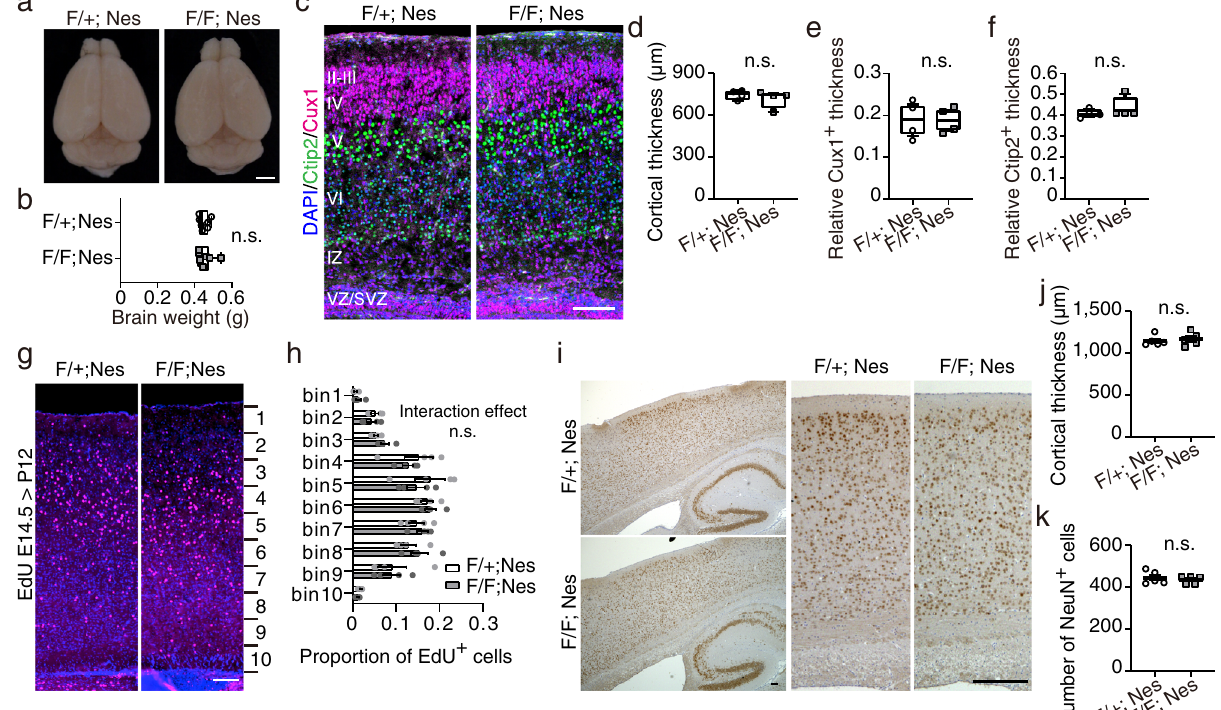
Fig. 3 Laminated structure in the cerebral cortex is preserved in Rab35 cKO mice. a Dorsal view of 3-month-old control and Rab35 cKO mice brains. Scale bar, 2 mm. b Brain weights of 3-month-old control ( n = 7) and Rab35 cKO ( n = 8) male mice. Mann – Whitney U -test, p = 0.8409. c Representative images of P0 cortices of the control and Rab35 cKO mice immunostained for Cux1 (magenta), Ctip2 (green), and DAPI (blue). Scale bar, 100 μ m. d – f Quanti fi cation of the cortical ( d ), relative Cux1-positive ( e ), and Ctip2-positive ( f ) layer thicknesses of P0 control ( n = 4) and Rab35 cKO ( n = 4) mice. Cux1-positive and Ctip2-positive layer thicknesses were measured and normalized against total cortical thickness. Mann – Whitney U - test; d , p = 0.6857; e , p >0.99; f , p = 0.2. g Representative EdU labeling birthdate analysis images of P12 cortex samples stained with EdU (magenta) and DAPI (blue). Scale bar, 100 μ m. h Proportion of EdU-positive neurons in P12 cortices of control ( n = 4) and Rab35 cKO ( n = 4) mice. Two-way repeated-measures ANOVA with Bonferroni correction; interaction effect, F(9, 54) = 0.4991, p = 0.8687. i Immunohistochemistry of sagittal sections of cerebral cortices of 4-month- old control and Rab35 cKO mice using an anti-NeuN antibody. Scale bars, 100 μ m. j , k Quantitative analysis of the cortical thickness ( j ) and the number of NeuN-positive cells in the 300- μ m width cerebral cortex ( k ) of the control ( n = 5) and Rab35 cKO ( n = 5) mice. Unpaired Student ’ s t -test; j , p = 0.6928; k , p = 0.5375. Data represent mean ± SEM or box and whisker plots; box plot shows 25 th and 75 th percentiles (box), median (horizontal bar), and minimum to maximum (whiskers); n.s., not signi fi cant ( p >